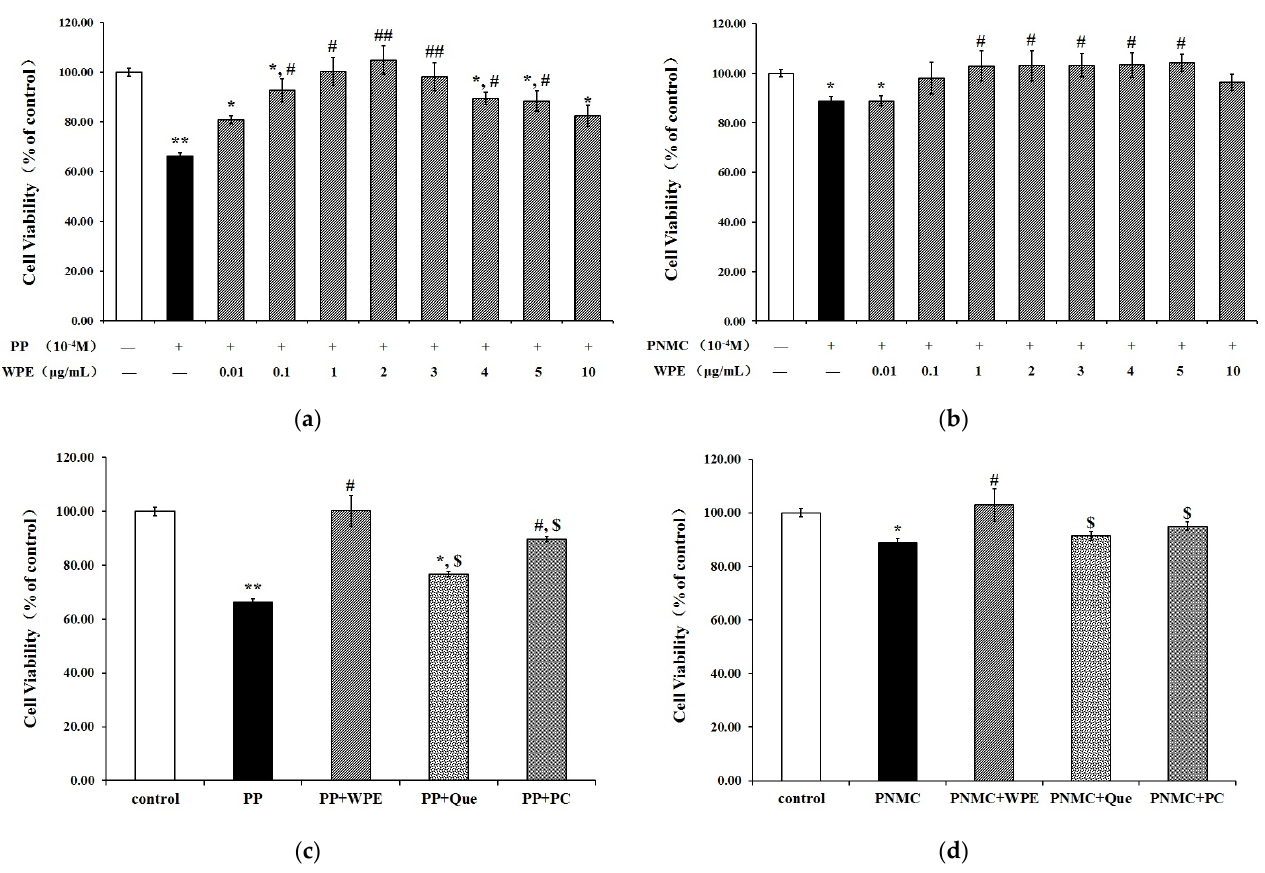
Figure 1. Effect of WPE on cytotoxicity in splenocytes exposed to PP/PNMC. Splenocytes were treated with ( A ) PP (10 − 4 M) or different concentrations (0.01, 0.1, 1.0, 2.0, 3.0, 4.0, 5.0, and 10.0 μ g/mL) of WPE together with PP; ( B ) PNMC (10 − 4 M) or different concentrations (0.01, 0.1, 1.0, 2.0, 3.0, 4.0, 5.0, and 10.0 μ g/mL) of WPE together with PNMC; ( C ) PP (10 − 4 M) or WPE (1.0 μ g/mL), Que (1.0 μ g/mL), PC (1.0 μ g/mL) together with PP ( D ) PNMC (10 − 4 M) or WPE (1.0 μ g/mL), Que (1.0 μ g/mL), PC (1.0 μ g/mL) together with PNMC for 48 h. Que, quercetin; PC, proanthocyanidin. Results shown are means ± SD of three separate experiments. * p < 0.05 or ** p < 0.01 vs. untreated control; # p < 0.05 or ## p < 0.01 vs. PP or PNMC treatment; $ p < 0.05 vs. WPE (1.0 μ g/mL), together with PP (10 − 4 M) or PNMC (10 − 4 M) treatment.